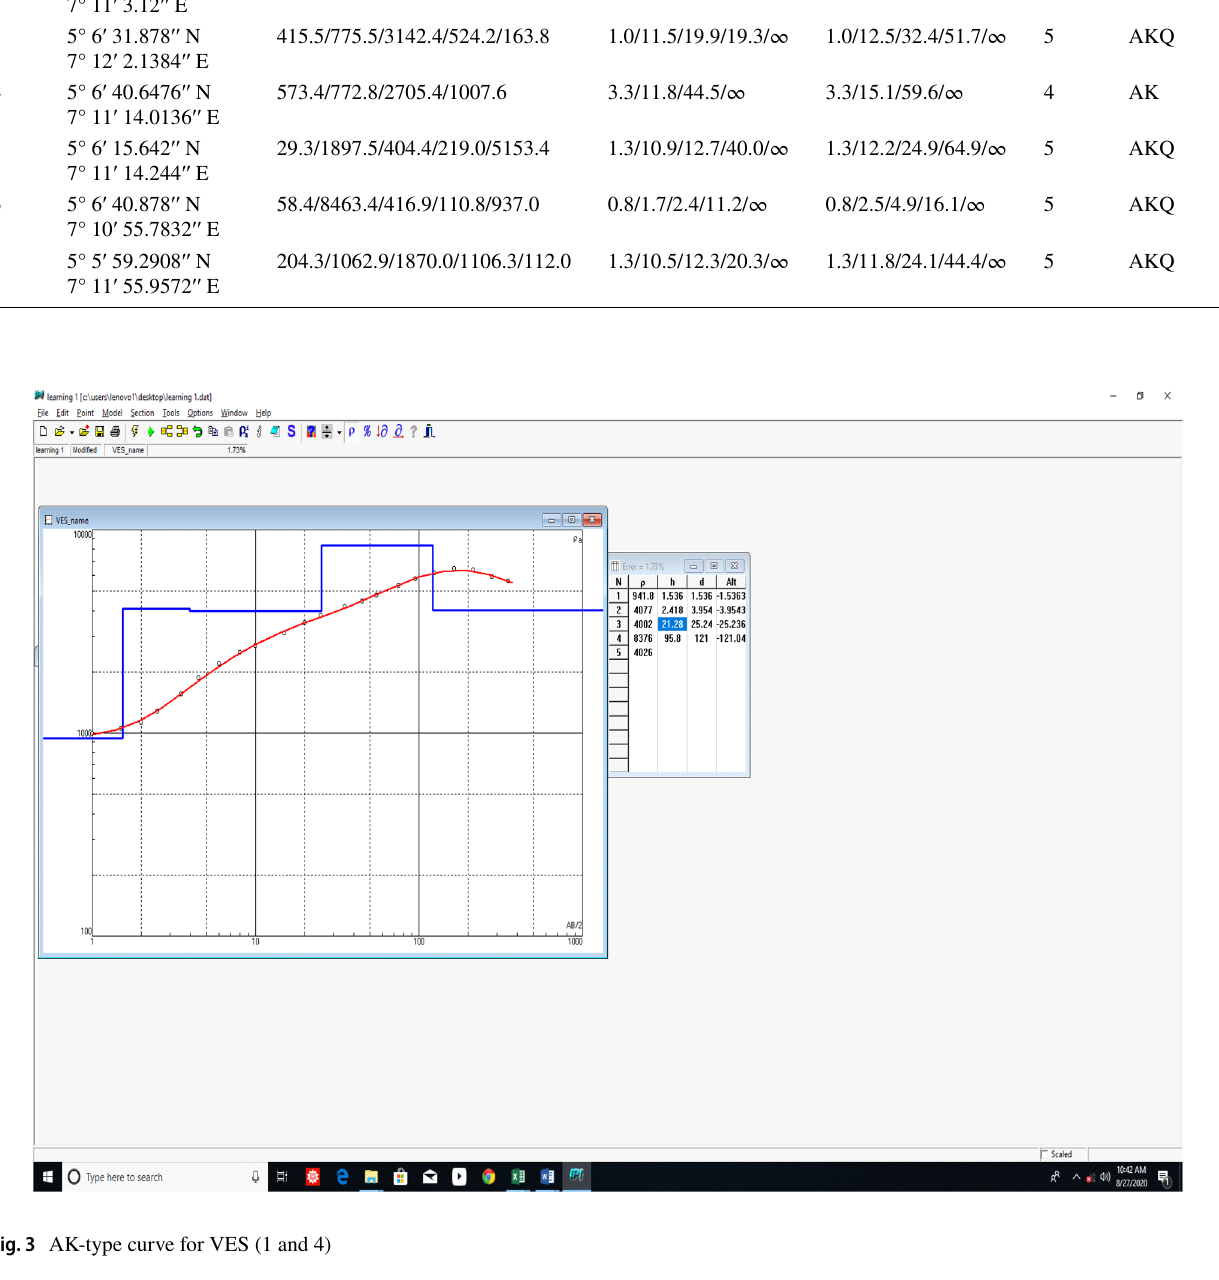
Fig. 3 AK-type curve for VES (1 and